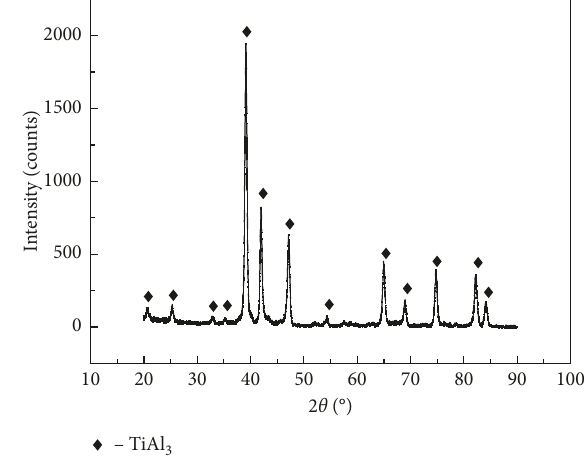
Figure 4: XRD spectrum after removal of 500 μ m thick surface